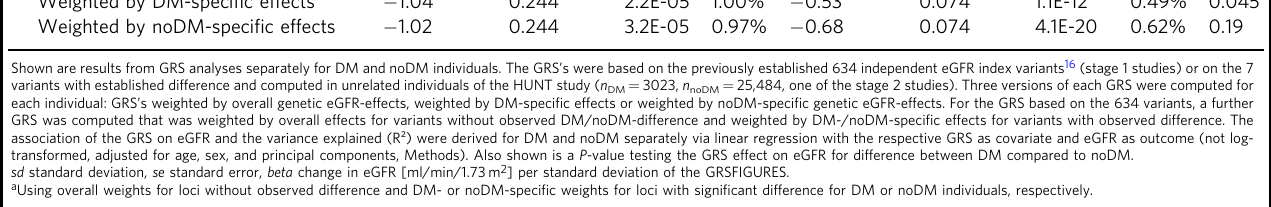
Shown are results from GRS analyses separately for DM and noDM individuals. The GRS ’ s were based on the previously established 634 independent eGFR index variants 16 (stage 1 studies) or on the 7 variants with established difference and computed in unrelated individuals of the HUNT study ( n DM = 3023, n noDM = 25,484, one of the stage 2 studies).Three versions of each GRS were computed for each individual: GRS ’ s weighted by overall genetic eGFR-effects, weighted by DM-speci fi c effects or weighted by noDM-speci fi c genetic eGFR-effects. For the GRS based on the 634 variants, a further GRS was computed that was weighted by overall effects for variants without observed DM/noDM-difference and weighted by DM-/noDM-speci fi c effects for variants with observed difference. The association of the GRS on eGFR and the variance explained (R²) were derived for DM and noDM separately via linear regression with the respective GRS as covariate and eGFR as outcome (not log- transformed, adjusted for age, sex, and principal components, Methods). Also shown is a P -value testing the GRS effect on eGFR for difference between DM compared to